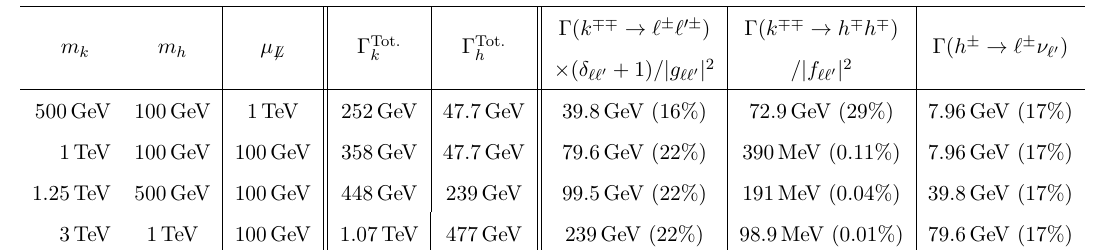
Table 2 . For masses m k , m h and coupling µ 6 L (columns 1–3), the total widths Γ Tot .